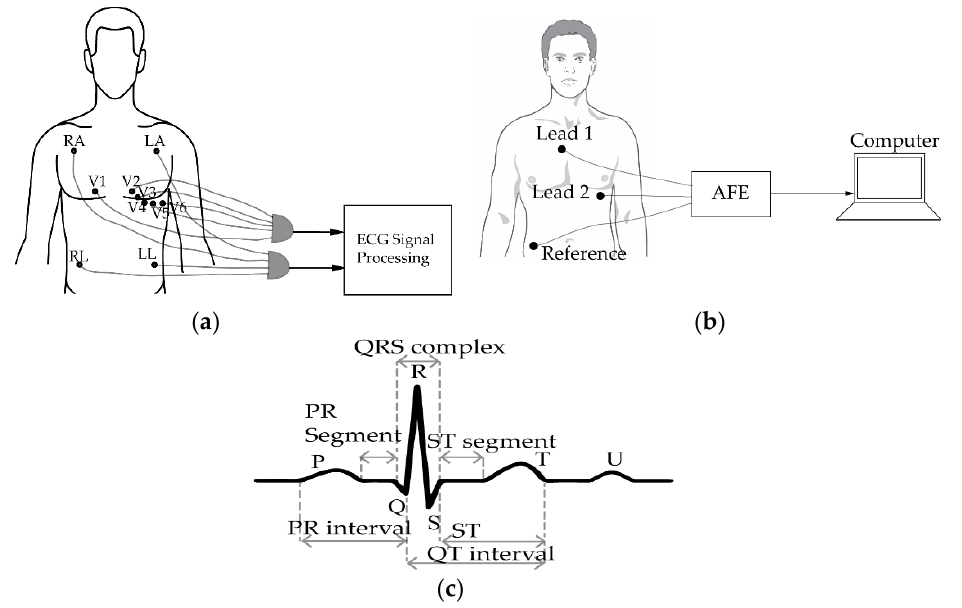
Figure 1. ( a ) Twelve-lead clinical electrocardiogram (ECG) system; ( b ) ambulatory ECG system; ( c ) representation of ECG signal.